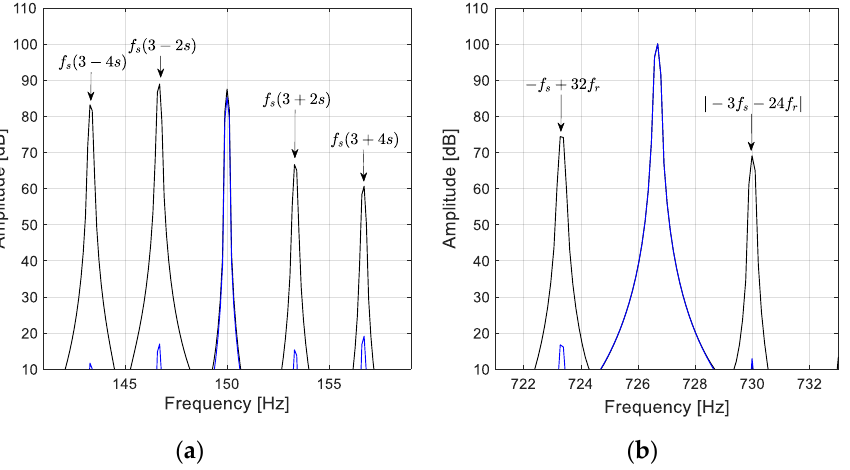
Figure 13. ZSC spectra comparison of motor with delta stator winding connection, healthy (blue color), with broken rotor cage (black color) around: ( a ) triple supply frequency, (b ) base slot harmonic.